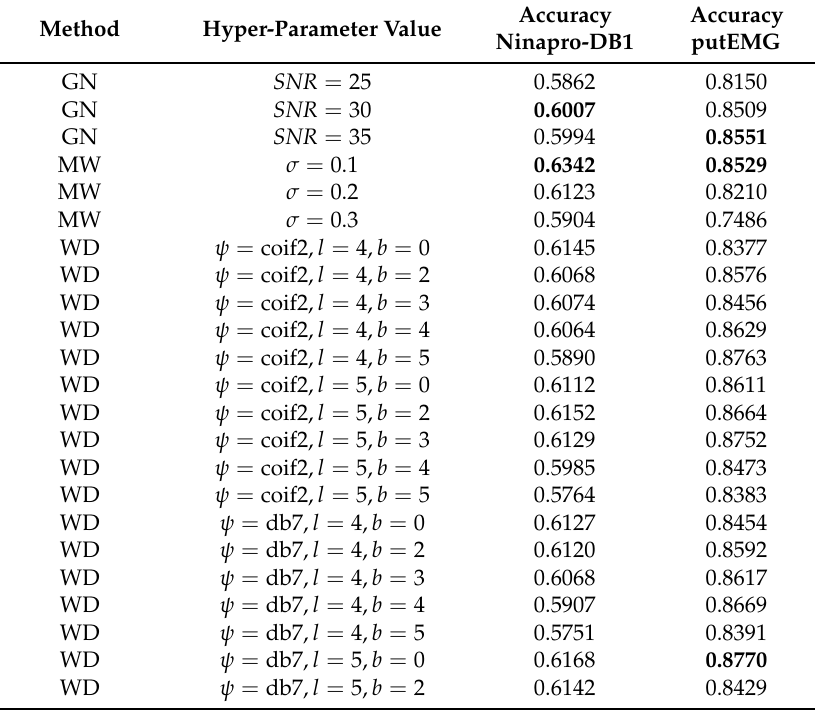
Table A5. Augmentation hyper-parameter selection results. For each method and dataset, higher accuracy is shown in